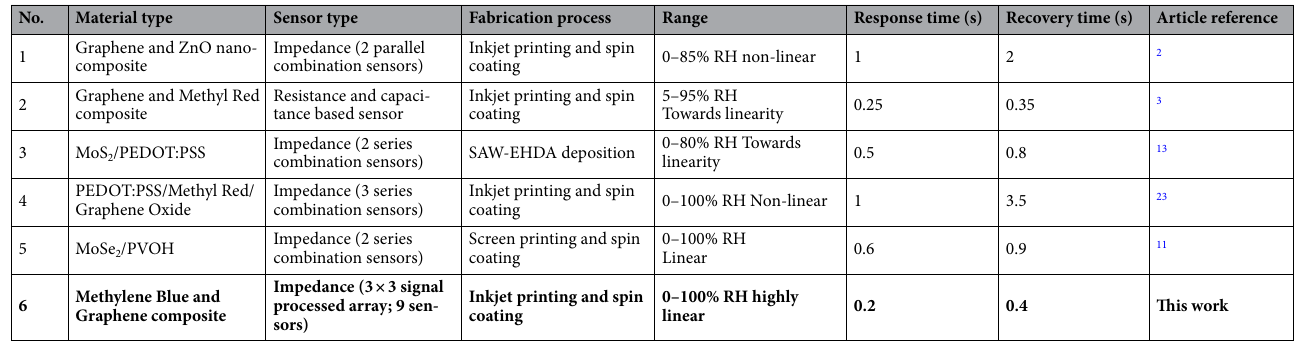
Table 1. Comparison of Graphene and array based humidity